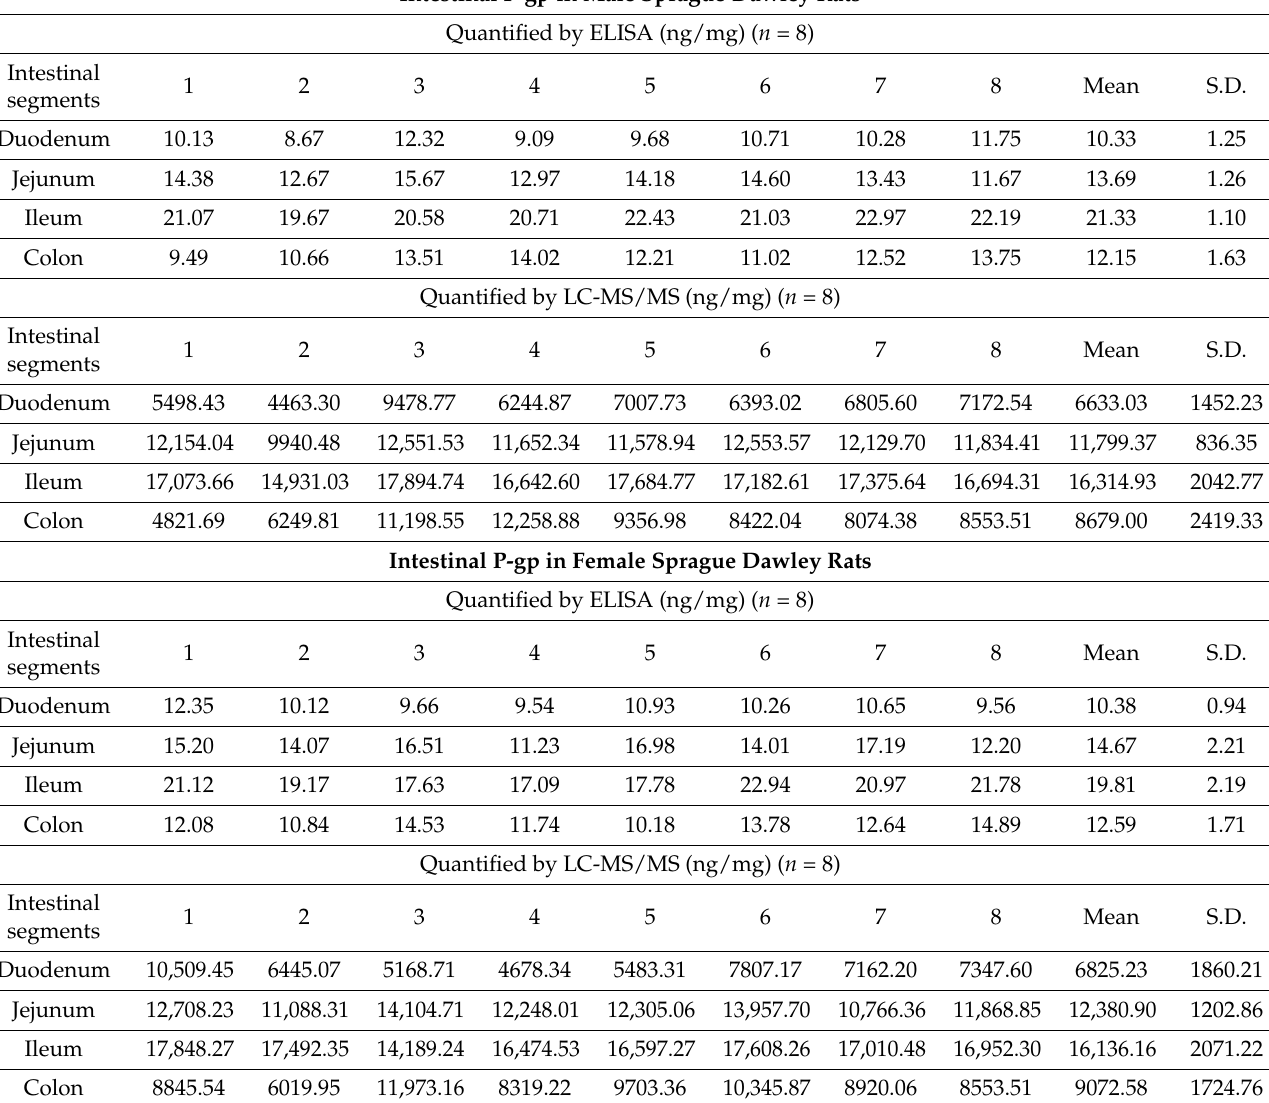
Table 3. P-glycoprotein expression in male and female Sprague Dawley rats quantified by enzyme- linked immunosorbent assay (ELISA) and liquid chromatography–tandem Mass spectrometry (LC-